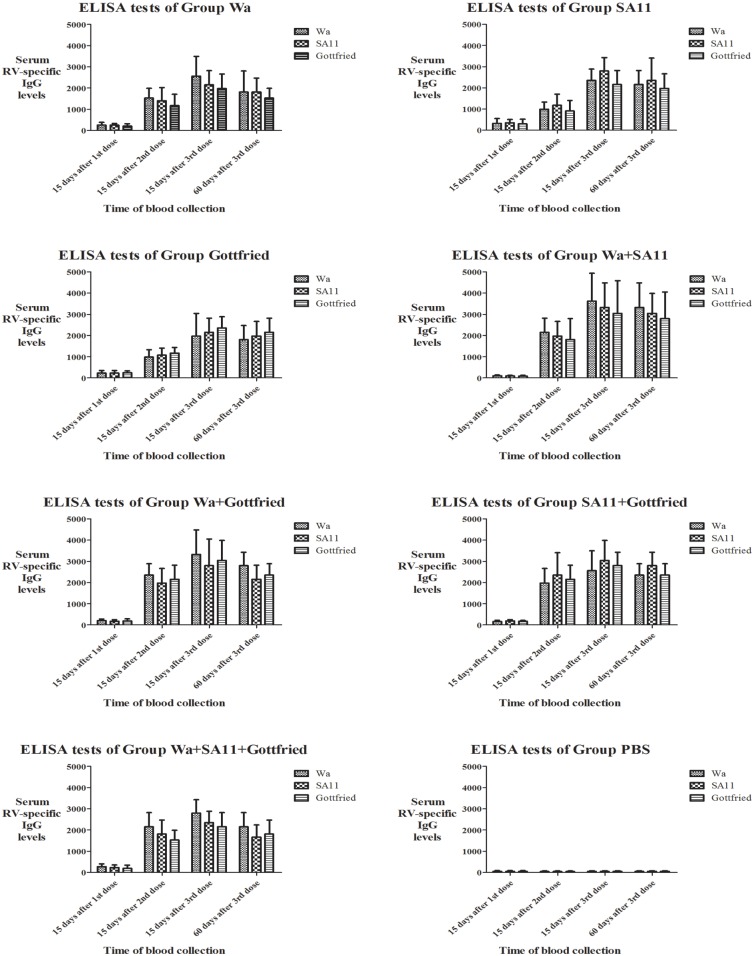
ELISA test results of every group.The serum RV-specific IgG levels of each serum sample in every group were detected by ELISA tests against all the three RV immunogens Wa (G1P[8] genotype), SA11 (G3P[1] genotype) and Gottfried (G4P[6] genotype) after every dose. Data were expressed as GM*GSE±tα/2,ν. GM stood for Geometric Mean. GSE stood for Geometric Standard Error. In this study, α = 0.05 and ν = n-1 = 8–1 = 7, so the corresponding t value was able to be found according to the tables for statistical distributions (t-distribution). The heights of columns were based on the GM of each test and the error bar stood for the 95% confidence interval.